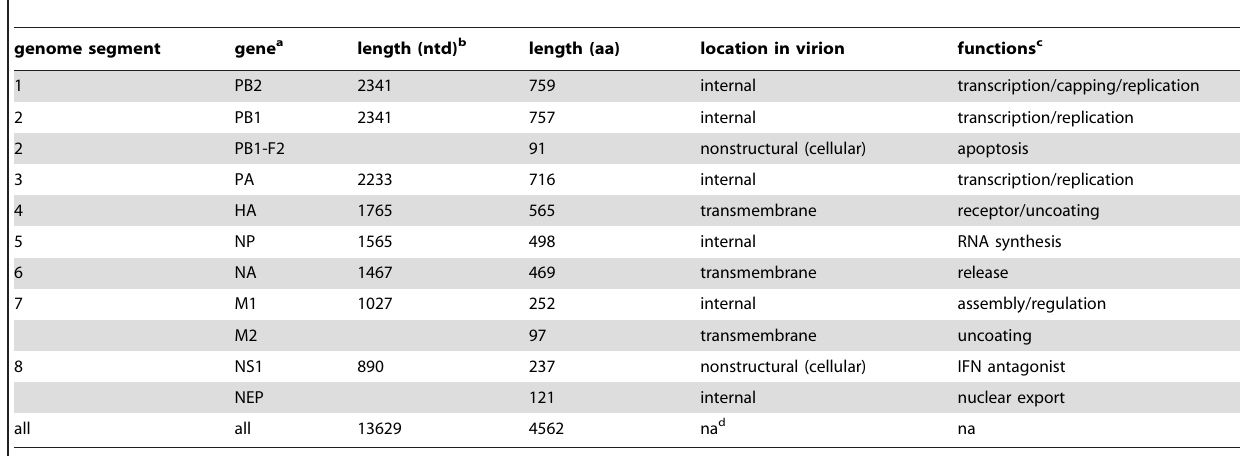
Table 1. Influenza A virus genome structure and